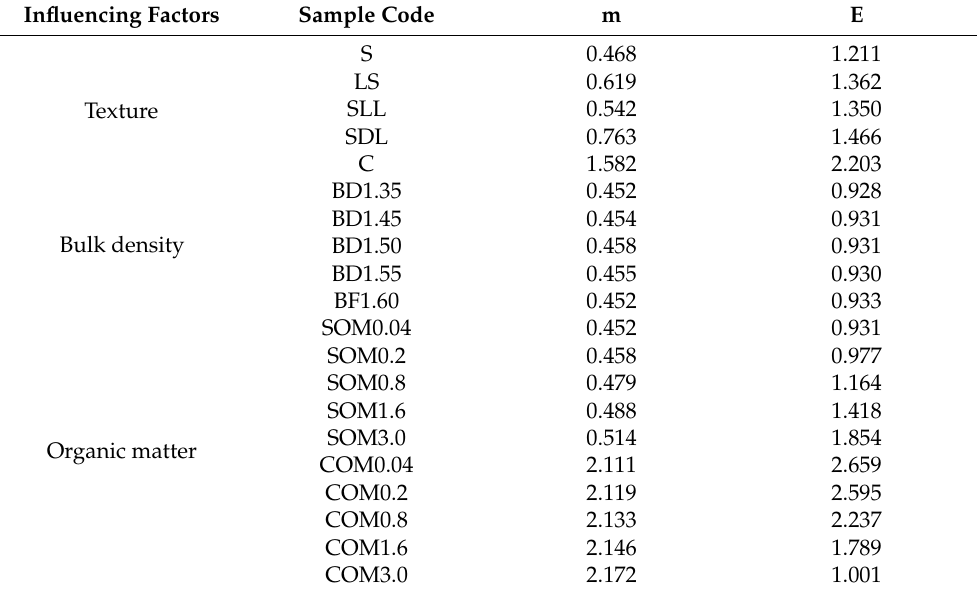
Table 6. The values of m and E of the soil